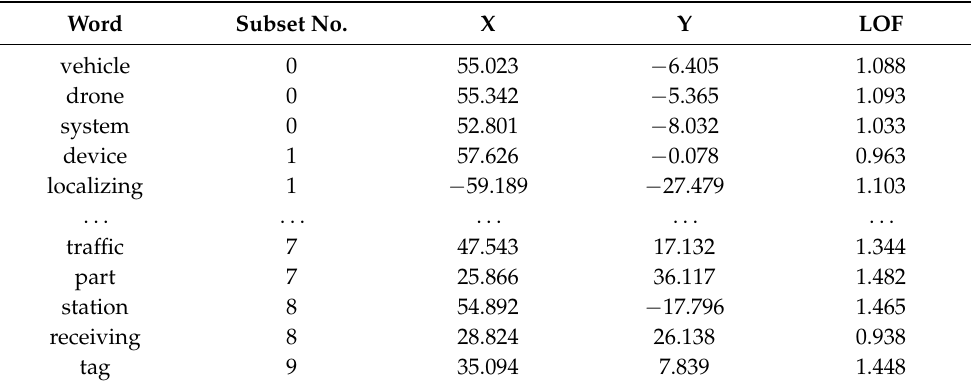
Table 5. Sample for LOF of keywords.